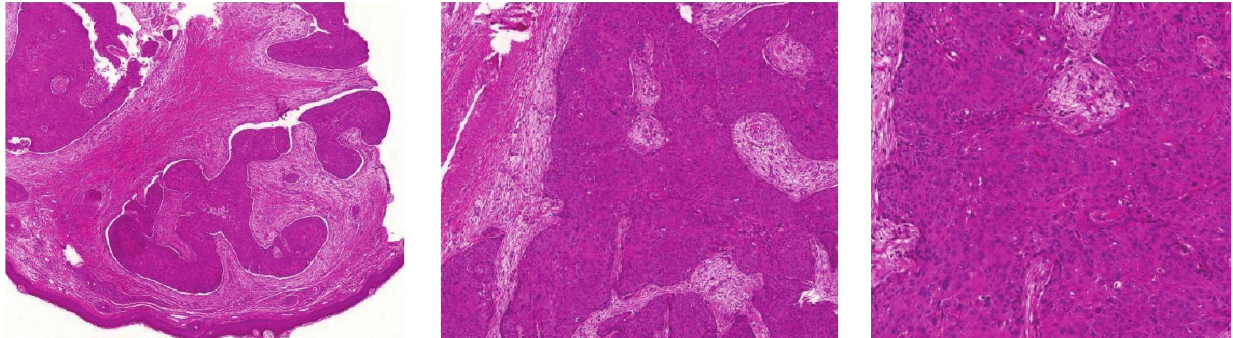
Figure 2: Histopathological examination: fibrous connective tissue partly covered by an intact nondysplastic squamous epithelium. The corial connective tissue is infiltrated by nonkeratinizing squamous cells with pleomorphism of size and nuclei, corresponding to a moderately differentiated squamous cell carcinoma (HE-staining, magnification × 20, × 50, and ×